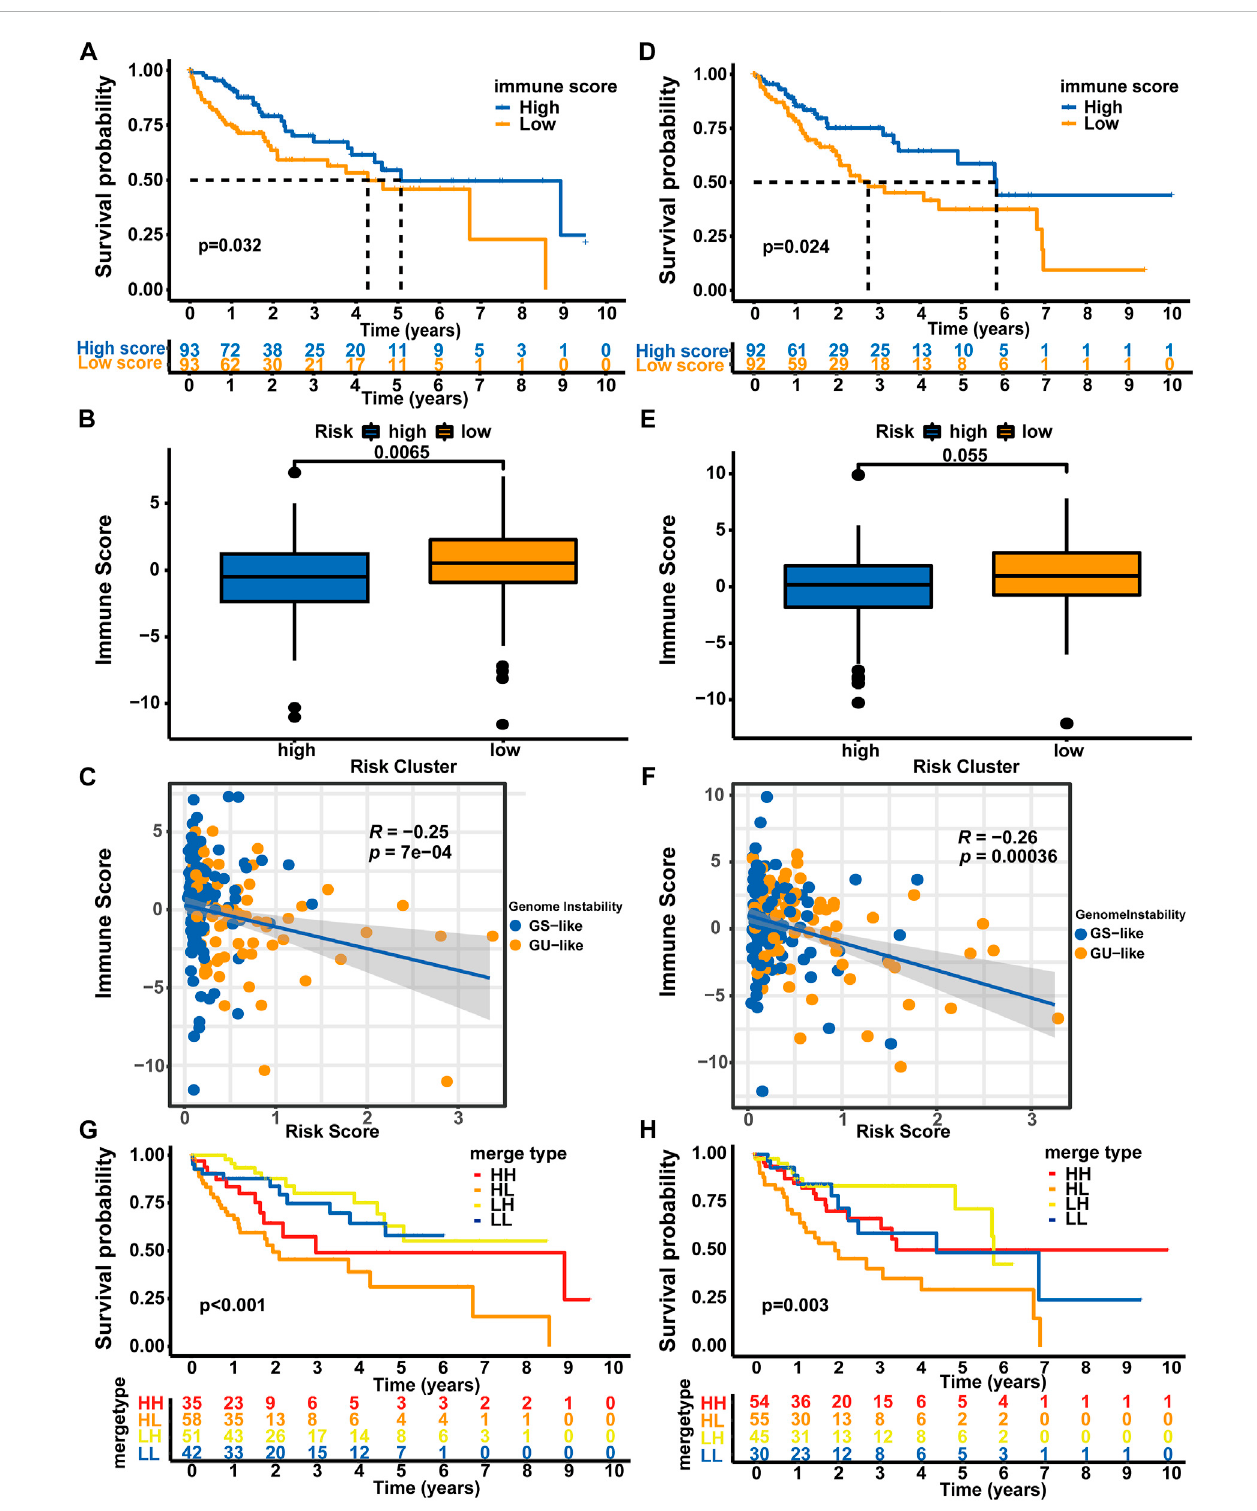
FIGURE 6 Combined analysis ofGLncM and theimmune microenvironment. Kaplan ‒ Meiercurvesfor thehigh and low immune score groups inthe training set (A) and veri fi cation set (D) . Difference in theimmunescores betweenthe high- and low-risk subgroups in the training set (B) and veri fi cation set (E) . Scatter plots showing the negative correlation between immune scores and risk scores in the training set (C) and testing set (F) . Kaplan ‒ Meier curves for patients in the training set (G) and veri fi cation set (H) strati fi ed by both the immune score and risk score. The log-rank test and Spearman ’ s correlation analysis were applied for statistical analyses. GS-like: genomic stable-like; GU-like: genomic unstable-like; HH: high risk score and high immune score; HL: high risk score and low immune score; LH: low risk score and high immune score; LL: low risk score and low immune